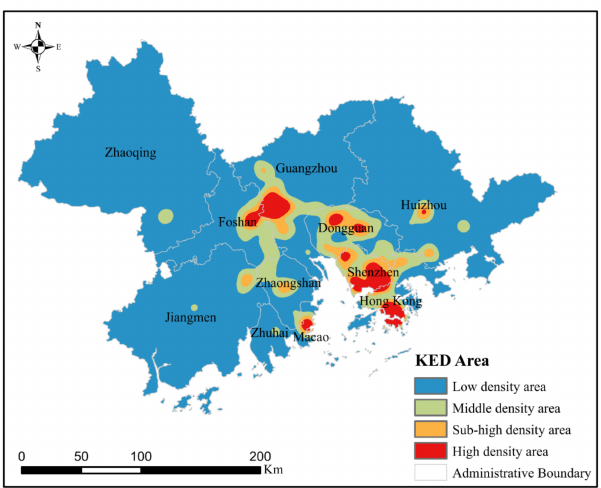
Figure 7. KDA of POI in Guangdong–Hong Kong–Macao Greater Bay